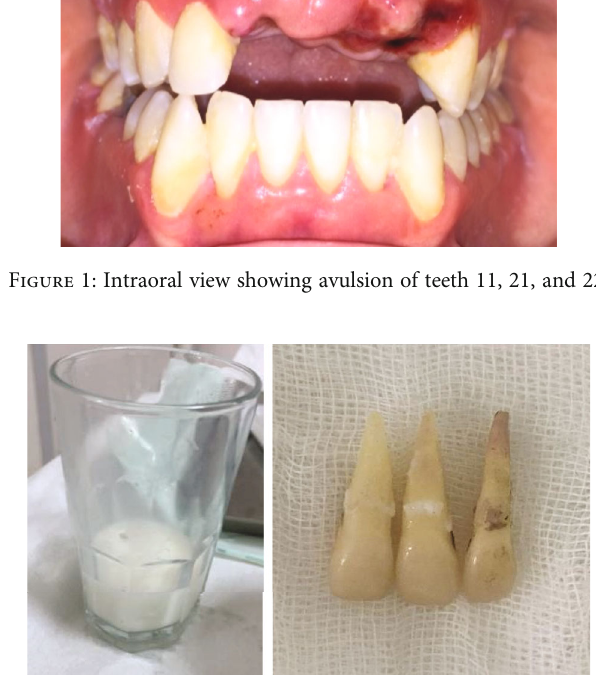
Figure 2: Avulsed teeth conserved in milk for 60 minutes — intact